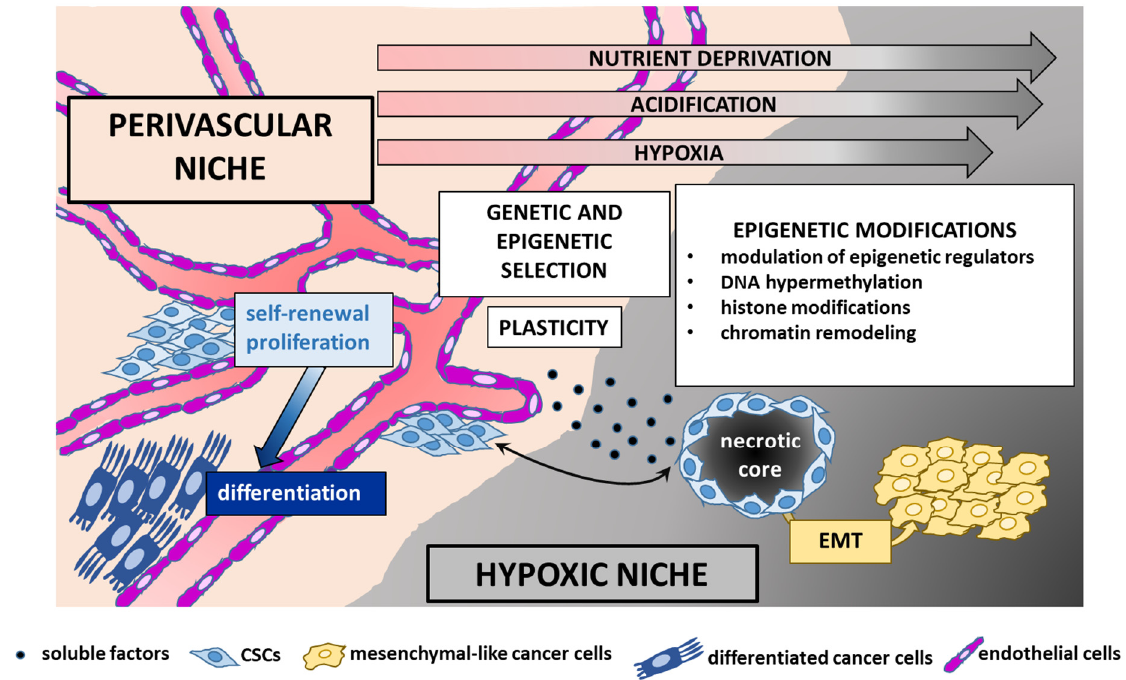
Figure 4. Schematic of the main factors that contribute to intra-tumoral heterogeneity in ependymoma. Genetic alterations and epigenetic modifications are selected in distinct tumor microenvironments, such as the perivascular and the hypoxic niche, that create gradients of oxygen, nutrients, and acidification. Changing contextual cues affect epigenetic regulators and remodel the chromatin landscape that mediates dynamic cellular plasticity. CSCs are able to adapt bidirectionally to both normoxic and hypoxic niches, fostering tumor growth and progression. Cross-talk among the distinct tumor and normal cell populations (such as endothelial cells) mediated by soluble factors or extracellular vesicles contributes to intra-tumoral cell-to-cell diversity. Cancer cells of the same phenotype tend to cluster together in the same topographical location. Differentiated cell concentrate in perivascular niches, whereas CSCs and mesenchymal-like cells coexist in hypoxic microenvironments, suggesting cooperative interactions and interconversion between these cell states (epithelial-to-mesenchymal transition, EMT).